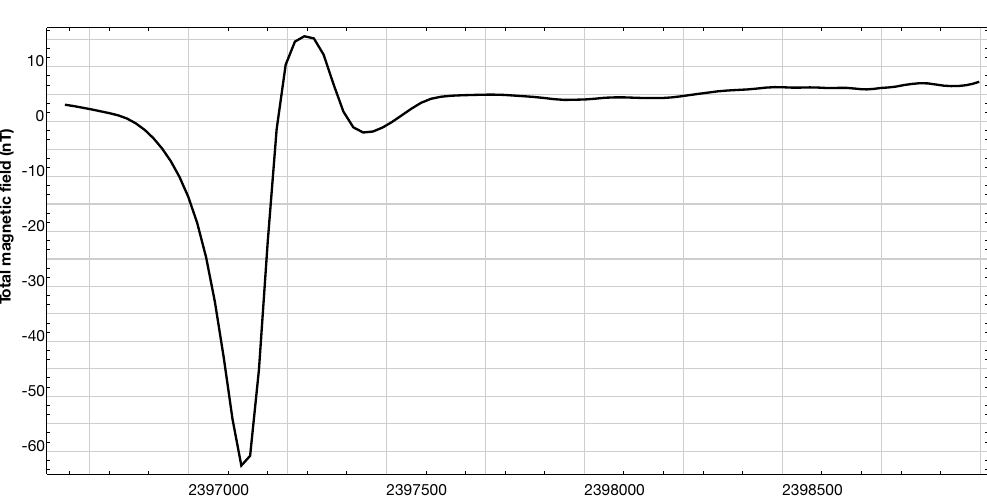
Fig. 5. Profile view displaying microlevelled total field HRAM signature over the domestic waste located in test site area